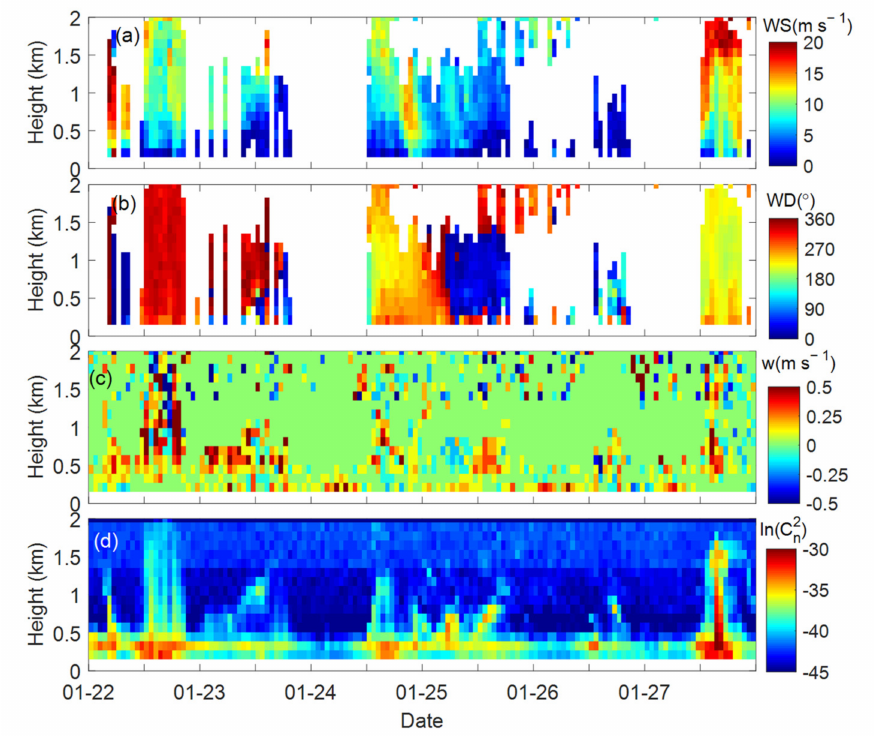
Figure 11. Height-time crossing sections of ( a ) wind speed, ( b ) wind direction, ( c ) vertical wind speed ( w ), and ( d ) refractive rate log( C 2 n ) observed by wind radar in Shenyang during 22–27 January 2021. The C 2 values at all levels were distinctly lower during the haze–fog mixed episode n than during the haze episode, which means that turbulence in the PBL was weaker. From 12:00 LT on 27 January, the C 2 values increased significantly compared to the period before n (with the order of its magnitude increasing from about 10 − 40 to above 10 − 35 ), and the strong turbulence activity contributed to the cessation of this air pollution